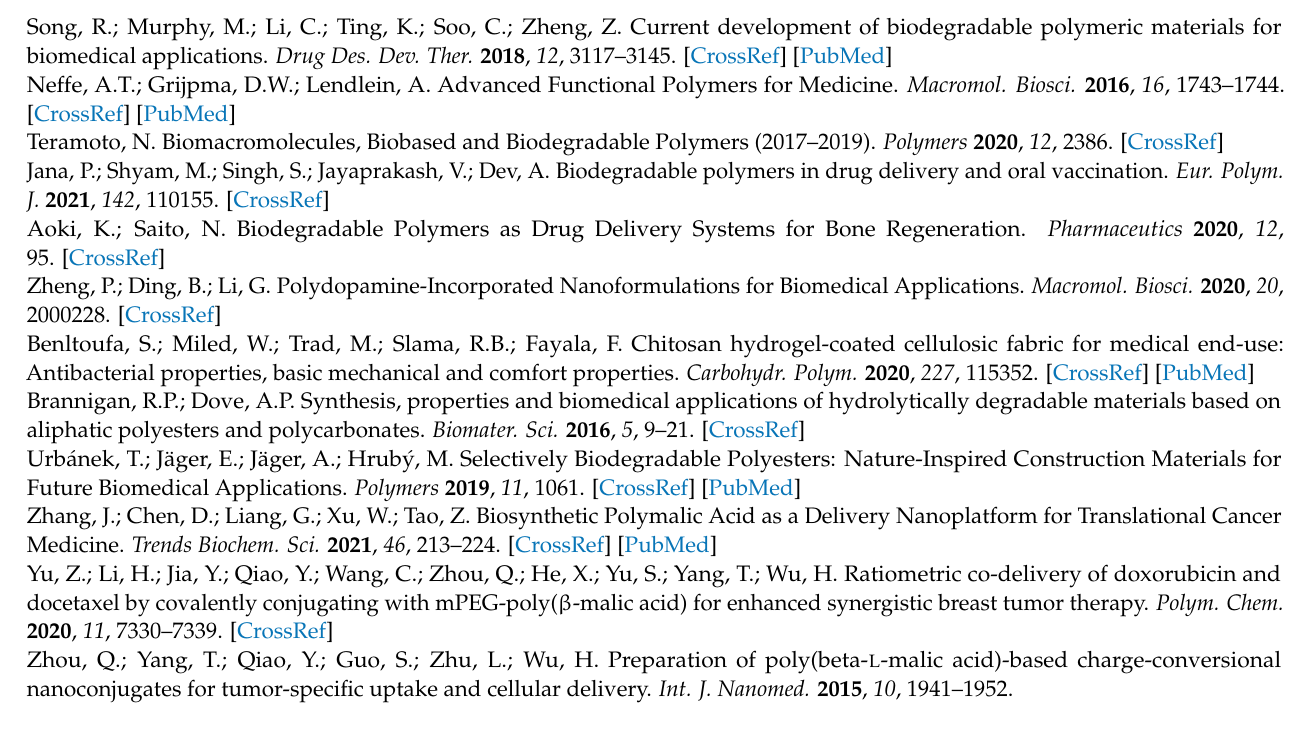
Supplementary Materials: The following are available online, Figure S1: (a) HPLC of MLABn from aspartic acid or malic acid by C18 column. (b) Corresponding retention time and purity of MLABn, Figure S2: Young’s modulus of PBM-2, Figure S3: Cell cycle analysis of PBM-2. (a) control group; (b) PBM-2. Table S1: The effect of reaction condition on the yield of MLABn, Table S2: The optical rotation values of the reagents and products, Table S3: The composition of C, H, and O in PBM, Table S4: Molecular weight and related thermodynamic parameters of